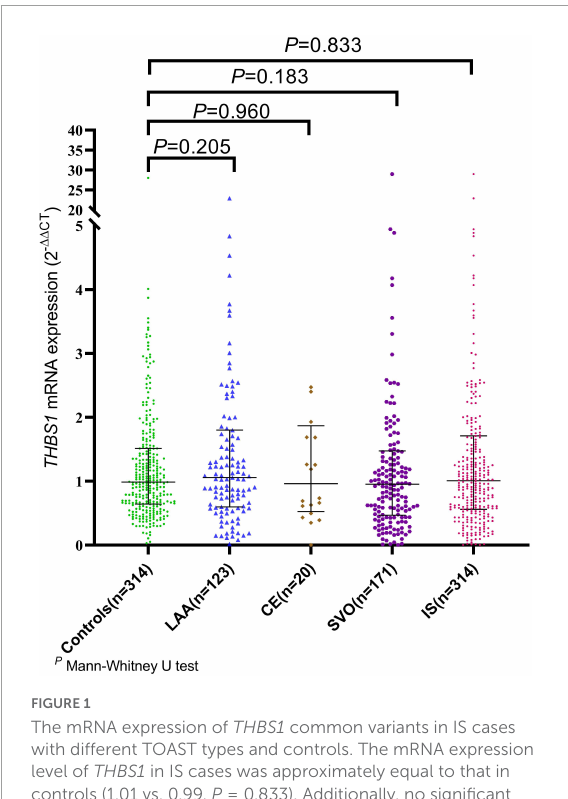
FIGURE1 The mRNA expression of THBS1 common variants in IS cases with different TOAST types and controls. The mRNA expression level of THBS1 in IS cases was approximately equal to that in controls (1.01 vs. 0.99, P = 0.833). Additionally, no significant difference in the THBS1 mRNA expression was detected between the three TOAST subgroups of IS cases and control group [LAA vs. controls: (1.09 vs. 0.99, P = 0.205), CE vs. controls: (0.96 vs. 0.99, P = 0.960), SVO vs. controls: (0.96 vs. 0.99, P = 0.183)].